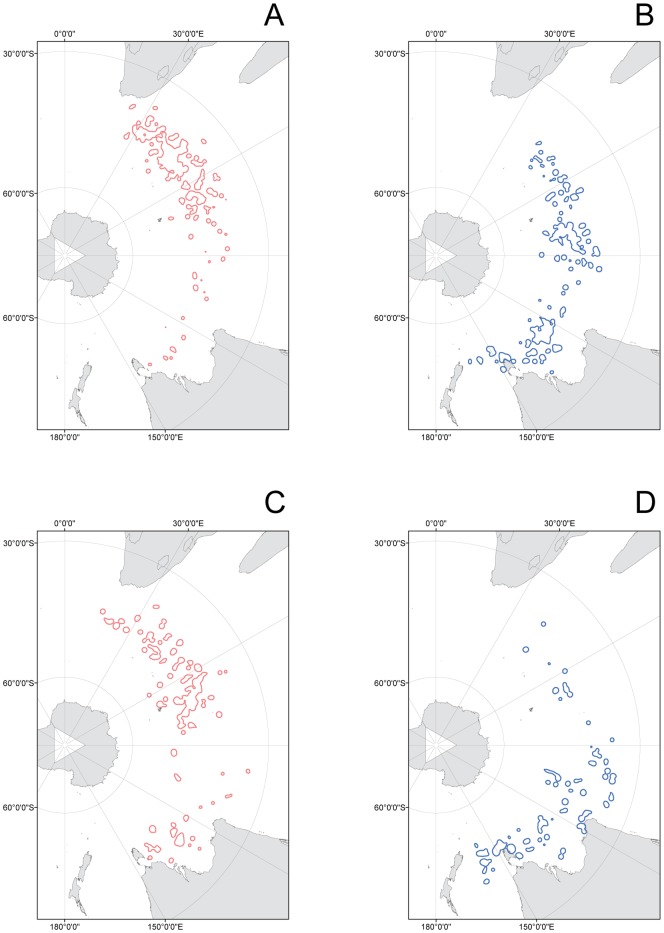
Ocean foraging zones for female and male juvenile wandering albatrosses migrating from Crozet Island as indicated by 75% kernel density zones for different time periods.(A) Juvenile females during January and February. (B) Juvenile males during January and February. (C) Juvenile females during March and April. (D) Juvenile males during March and April. The location of Crozet Islands is indicated by a star.